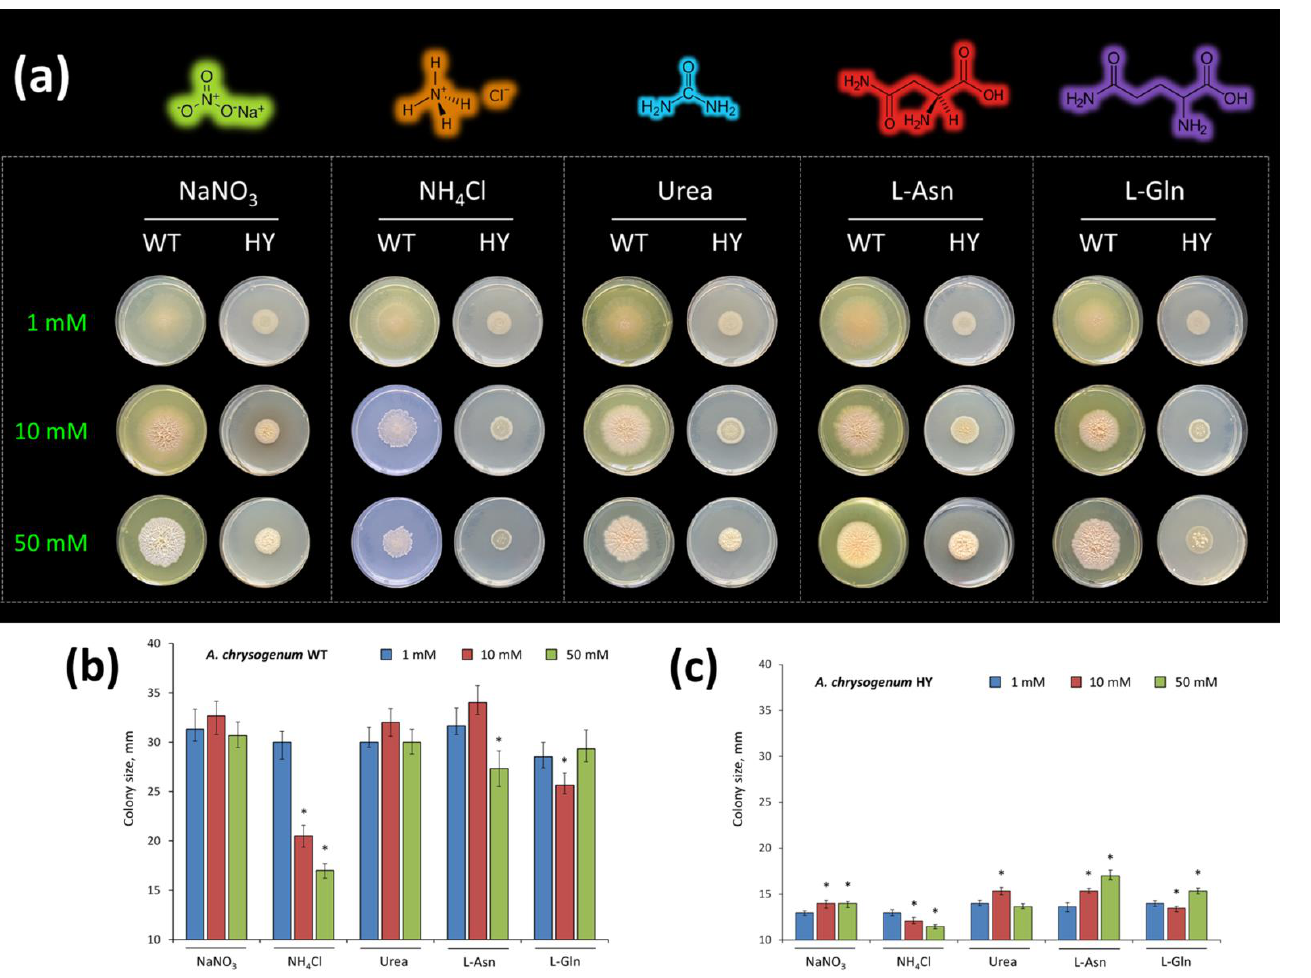
Figure 1. Growth of A. chrysogenum wild-type (WT) and high-yielding (HY) strains on agarized Czapek-N medium, supplemented with NaNO 3 , NH 4 Cl, or urea, or L-asparagine, or L-glutamine as sole nitrogen source at the concentration of 1 mM, 10 mM, or 50 mM after incubation for 20 days at 26 °С. ( a ) Phenotype on different media; ( b ) colony diameter size of A. chrysogenum WT strain, mm; ( c ) colony diameter size of A. chrysogenum HY strain, mm. Statistical significance, * p ≤ 0.05, as compared with the control (strain, cultivated on medium with 1 mM additions).